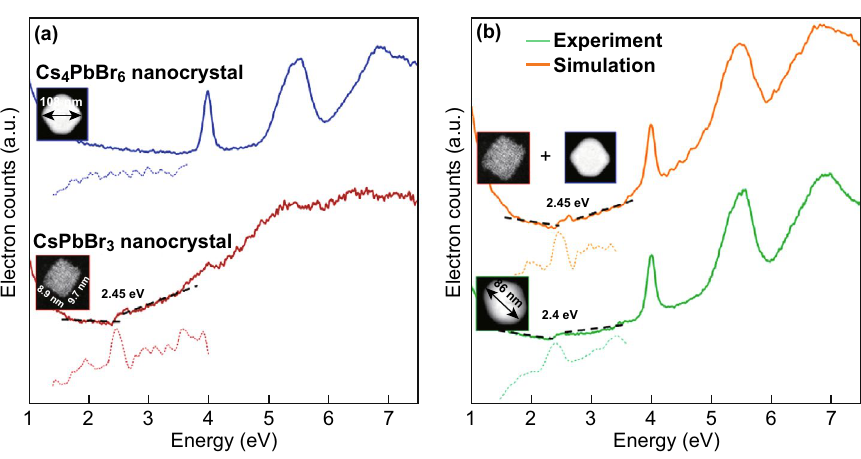
Fig. 12 Energy band gap and structure. a Valence-loss EEL spectra representing the absorption of a CsPbBr 3 nanocube (red spectrum) and a Cs 4 PbBr 6 NC (blue), appearing in the same sample (160 °C). The band gap energy of the nanocube (2.45 eV) is determined from the peak of the first derivative of the EEL spectrum, which appears due to the abrupt onset in absorption (indicated by the dotted lines). No onset is observed for the Cs 4 PbBr 6 NC which is an insulator with a large band gap energy of 4 eV. b Valence-loss EEL spectrum of a spherical nanocrystal (green) observed in the same sample, formed upon the hybridization of a nanocube and a nanohexagon. The latter process is represented by the simu- lated EEL spectrum (orange) which is obtained from adding the experimentally obtained spectra of the nanohexagon and nanocube as shown in a . The hybrid has, as expected, a band gap energy similar to that of the nanocube. Reprinted with permission from Ref. [31]. Copyright Ameri- can Chemical